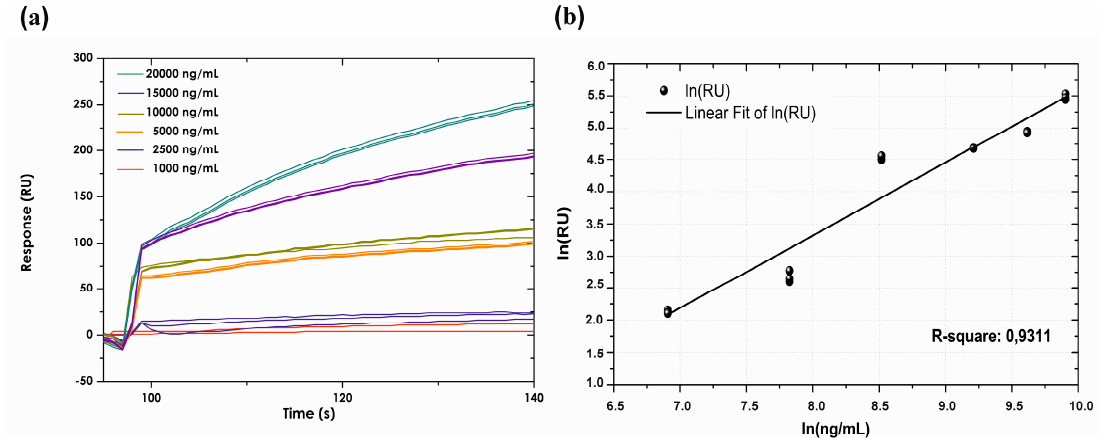
Figure 4. ( a ) Association and dissociation curves for the different adalimumab spiked concentrations in vitro. ( b ) Standard curve for resonance units (RU) compared to anti-human TNF- α . The concentration values used for the standard curve were 1.0, 2.5, 5.0, 10.0, 15.0 and 20.0 µg/mL. R-squared was 0.9311.